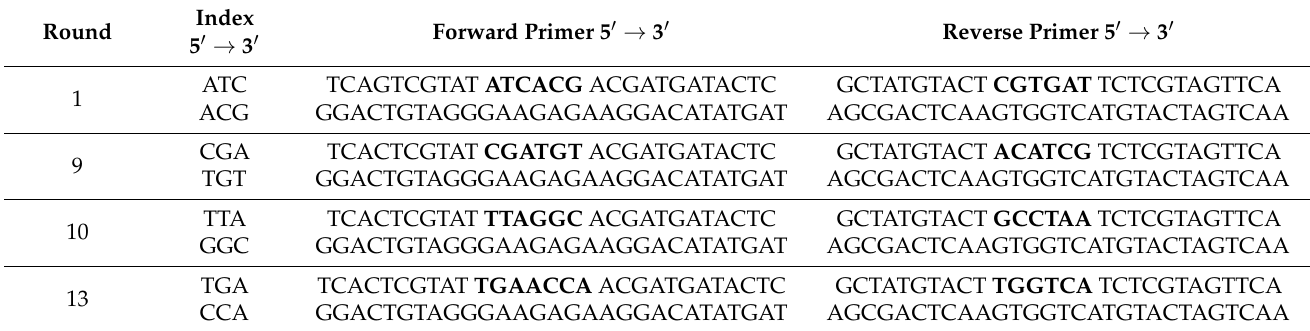
Table 1. Primers used for index introduction (index sequences are illustrated in